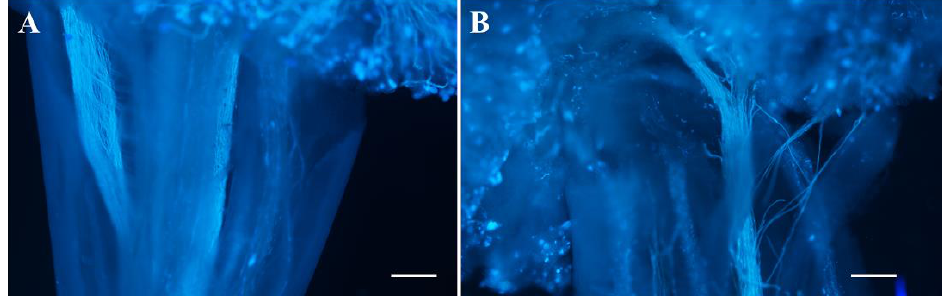
Figure 11. Fluorescence microscopic observation of pollen germination and pollen tube growth after pollination. ( A ) WT. ( B ) odd1 . Scale bars represent 200 μm. Table 2. Seed setting by selfing and hybridization.